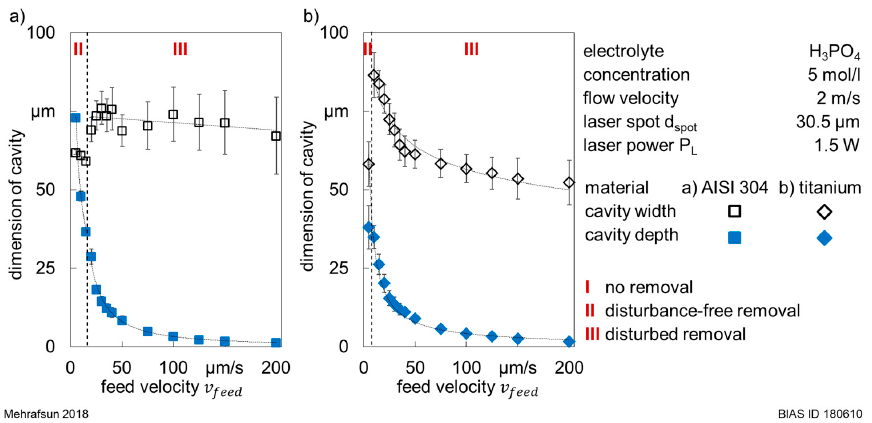
Figure 9. Width and depth of the resulting LCM cavities in ( a ) stainless steel and ( b ) titanium at a laser power P L of 1.5 W in dependence of the used feed velocity.